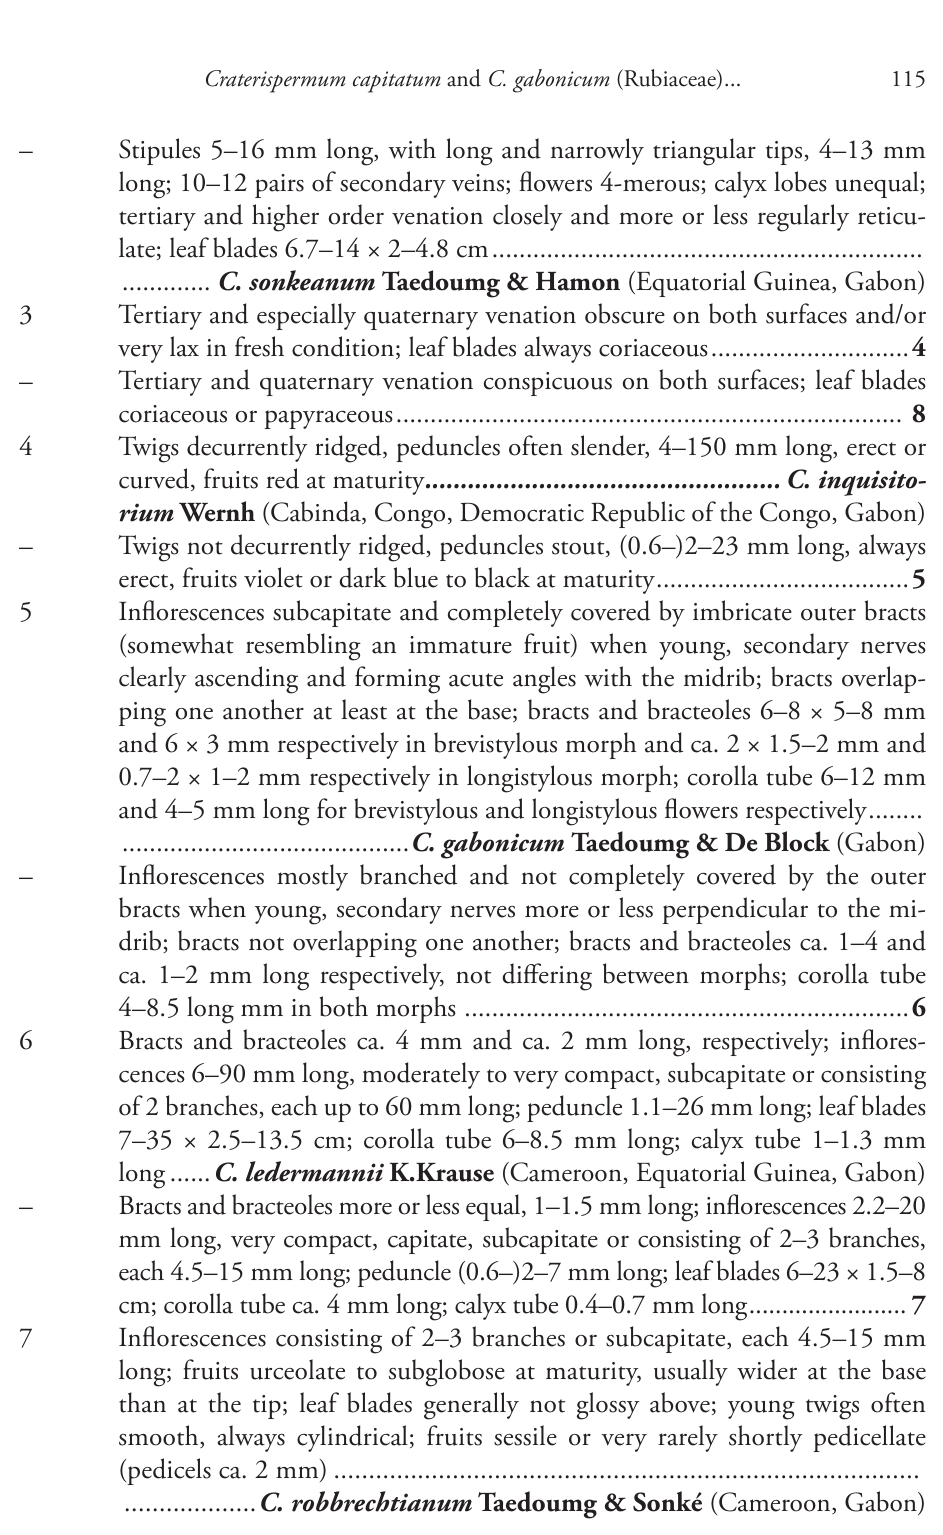
Tertiary and especially quaternary venation obscure on both surfaces and/or